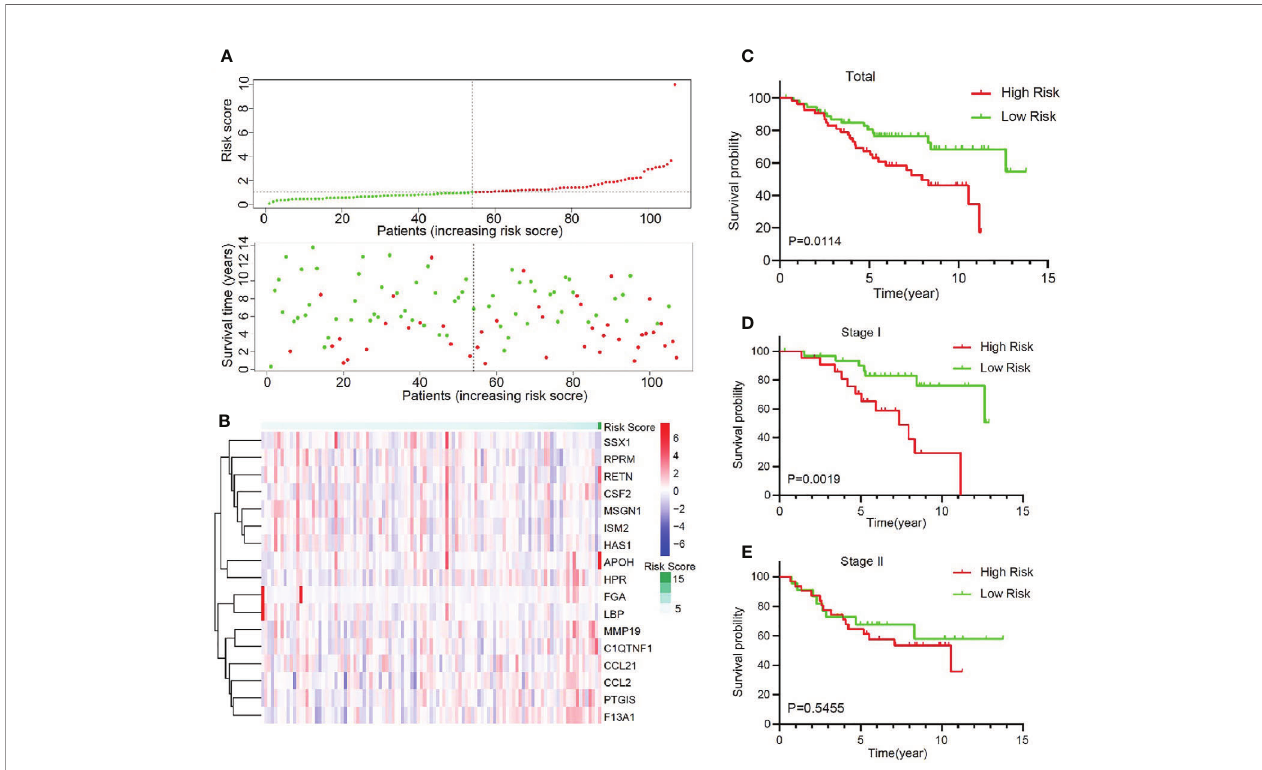
FIGURE 4 | Validation of the prognostic value of the key immune-related gene signature in GSE74777. (A) The distribution of risk score and survival status. (B) Distribution of speci fi c gene expression based on risk score. (C) Comparison of overall survival of all patients with early stage LUSC between high risk and low risk. (D, E) Kaplan – Meier curves of patients with stage I and stage II LUSC based on risk